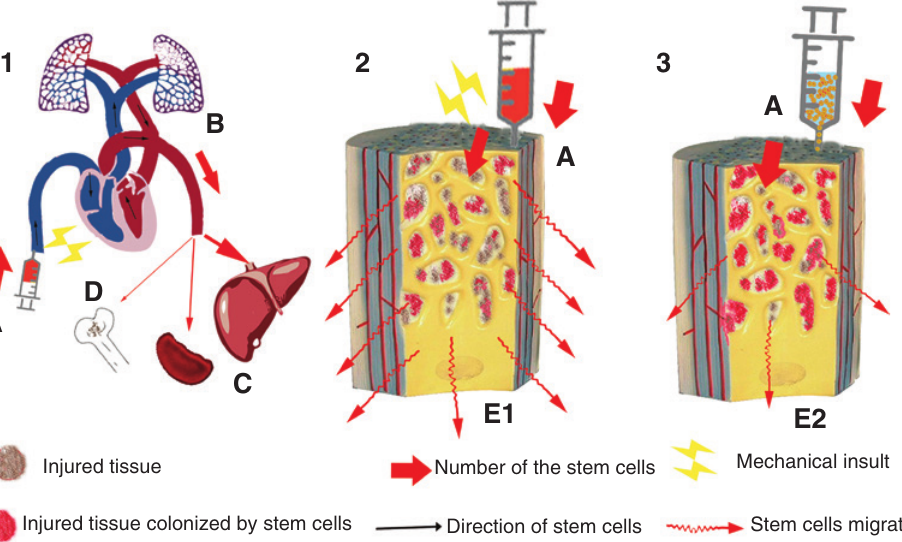
Figure 4: Symbolic schematic of three techniques to carry out stem cell transplantation. 1. Systematic administration by peripheral intravenous infusion. The size of the red arrow stands for the number of stem cells at the site they are arriving. After being consumed by mechanical insult during injection process (A), stranding at lung (B), liver and spleen (C), or other non-target site, only a small part of stem cells arrive at target site (D). 2. Direct injection of stem cells without assistance by competent 3 carriers. Without support of competent three carriers, they are prone to mechanical insult (A) and easily migrate out of the target sites (E1). 3. Direct injection of stem cells with assistance by competent 3D microcarriers, in which little or no mechanical insult is inflicted on stem cells and few stem cells migrate out of the target sites